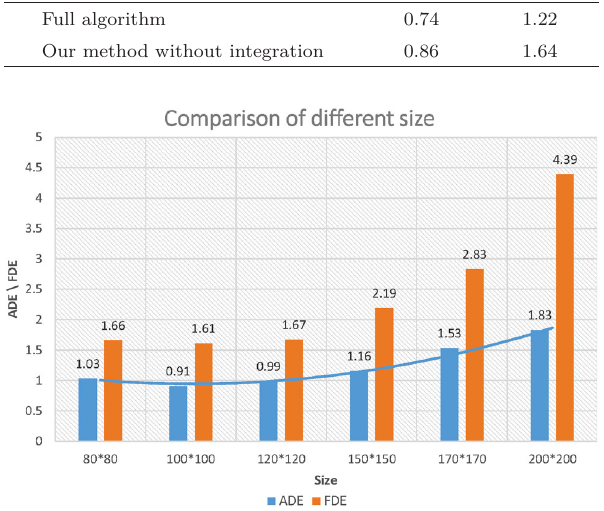
Fig. 6 Size of trajectory distribution. The blue line shows the trend of ADE. Experiments were conducted on the ETH dataset without data